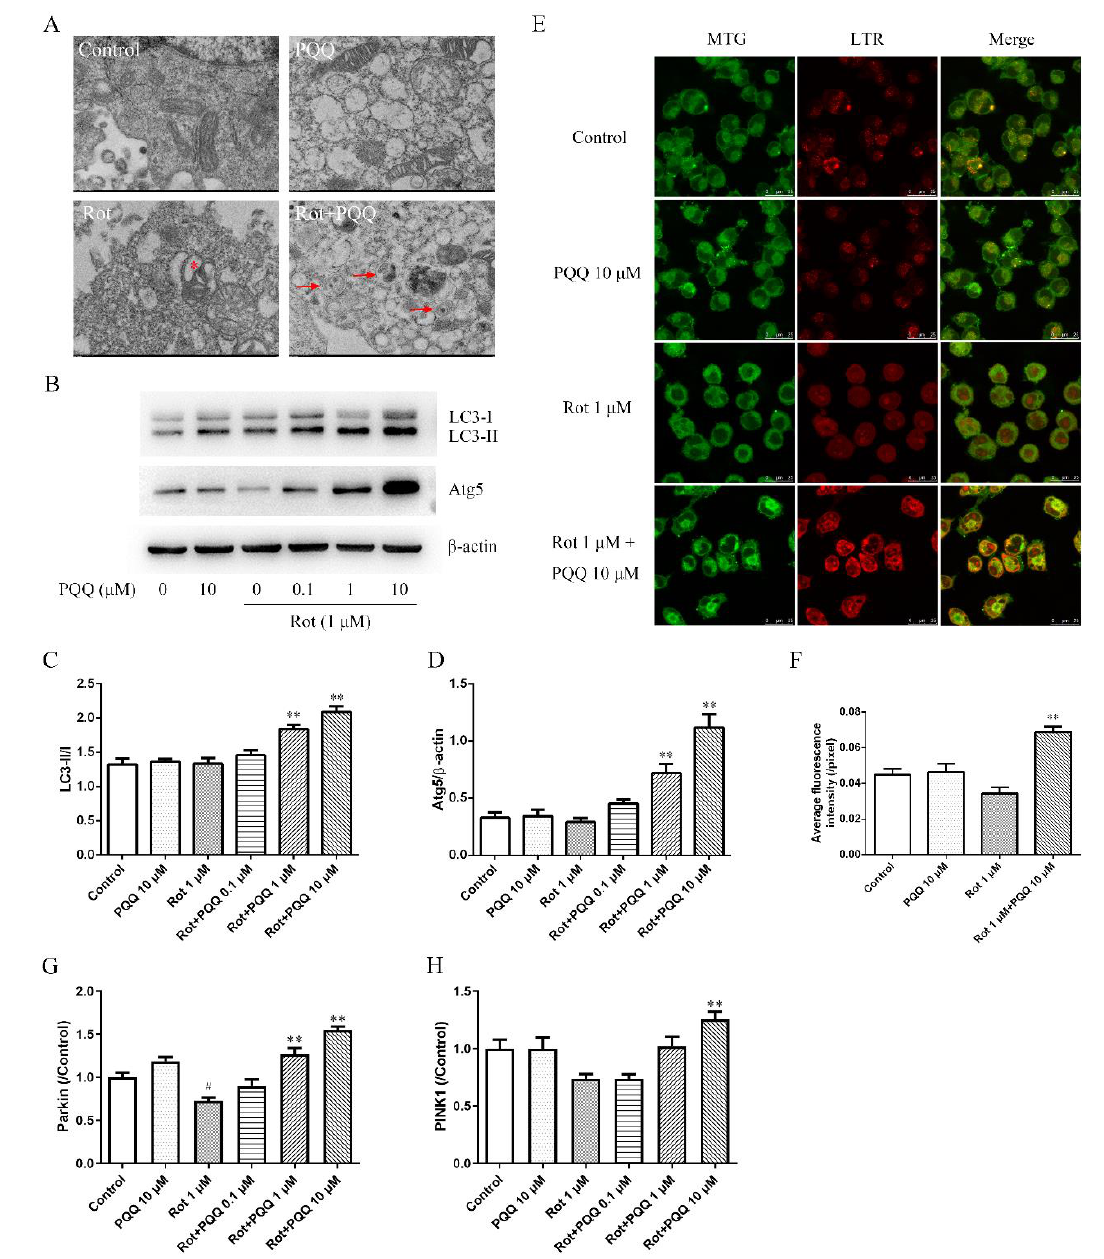
Figure 3. Autophagy was induced in BV2 microglia by PQQ. BV2 microglia cells were pre-treated with different doses of PQQ for 2 h before rotenone (1 μM) incubation for another 12 h. ( A ) Representative transmission electron microscopy (TEM) images of BV2 cells with different treatments as indicated. Asterisks indicate degenerated mitochondria. Arrows indicate autophagic vacuoles. Scale bar = 1 μm. ( B ) The protein expressions of LC3-I/LC3-II and autophagy related proteins 5 (Atg5) detected by Western blotting analysis. β-actin was used as a loading control. Quantification of the ratio of LC3-II/I ( C ) and the relative expression of Atg5 in BV2 cells ( D ). ( E ) Co-localization of mitochondria and lysosomes in BV2 cells detected by MitoTracker Green (MTG) and LysoTracker Red (LTR) staining. Cells with different treatments were incubated with 100 nM MTG and 100 nM LTR for 30 min. Images were acquired with a confocal microscope. Scale bar = 25 μm. ( F ) Average fluorescence intensity of MTG staining. Parkin ( G ) and PINK1 ( H ) mRNA expressions in BV2 cells measured by quantitative real-time reverse transcription PCR (qRT-PCR). The data were presented as the mean ± SEM from four independent experiments. ** p < 0.01 vs. rot group; # p < 0.05 vs. control group.